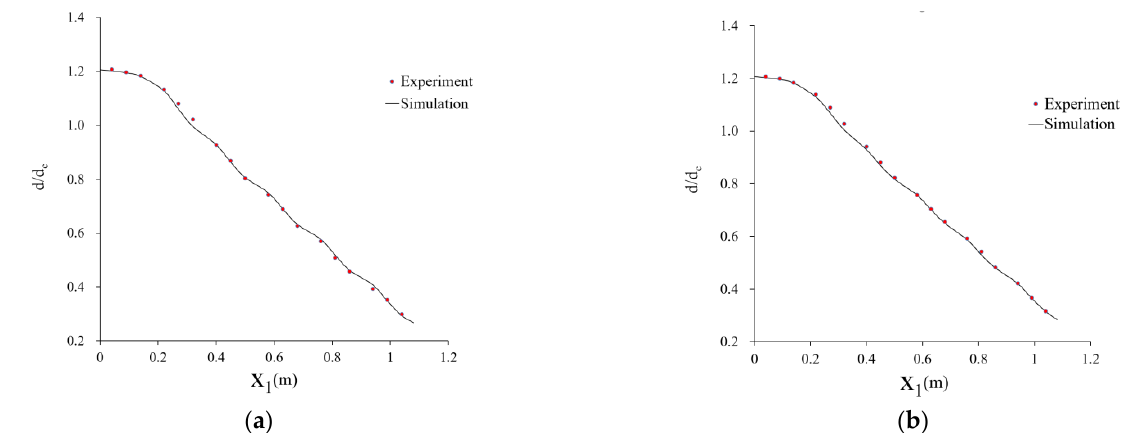
Figure 5. Comparison of simulated and experimental water depth: ( a ) Type I; ( b ) Type II.